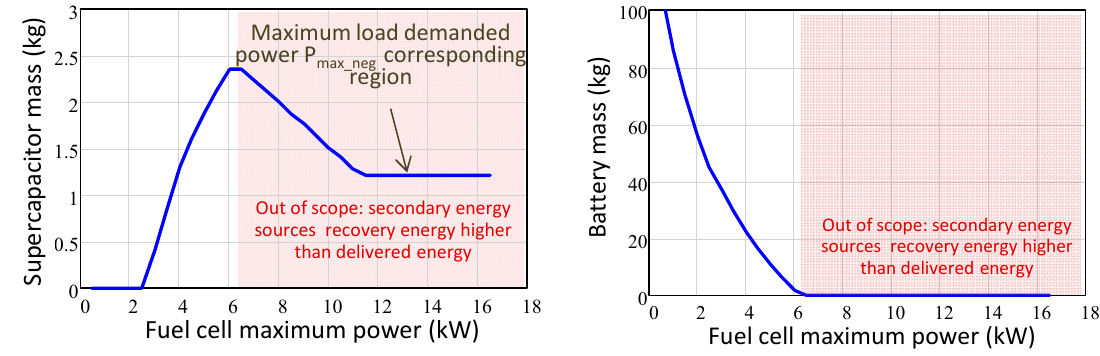
Figure 6. Equations system graphic solution in the first quadrant.